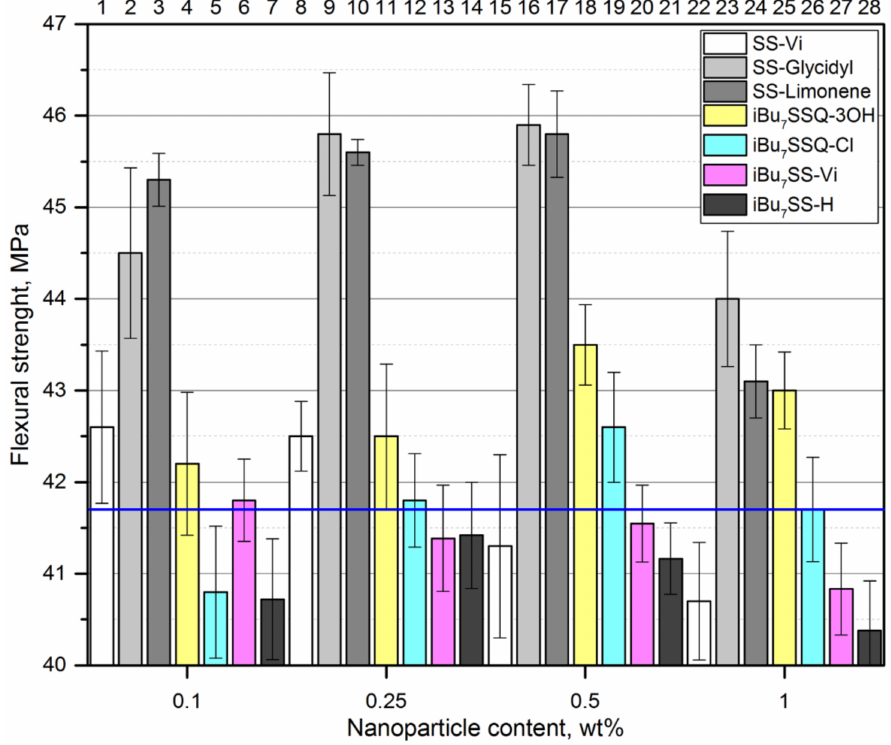
Figure 8. Flexural strength of the CS/iPP